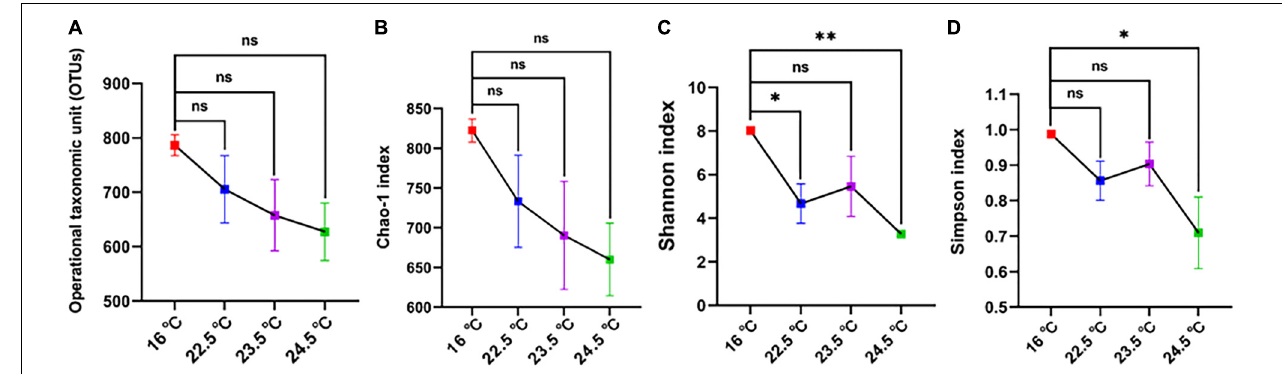
FIGURE 3 | Comparison of OTU levels and alpha diversity of intestinal microbiome in different temperature groups. (A) OTUs; (B) Chao-1 index; (C) Shannon index; (D) Simpson index; ∗ P < 0.05; ∗∗ P < 0.01; ns, no significance.